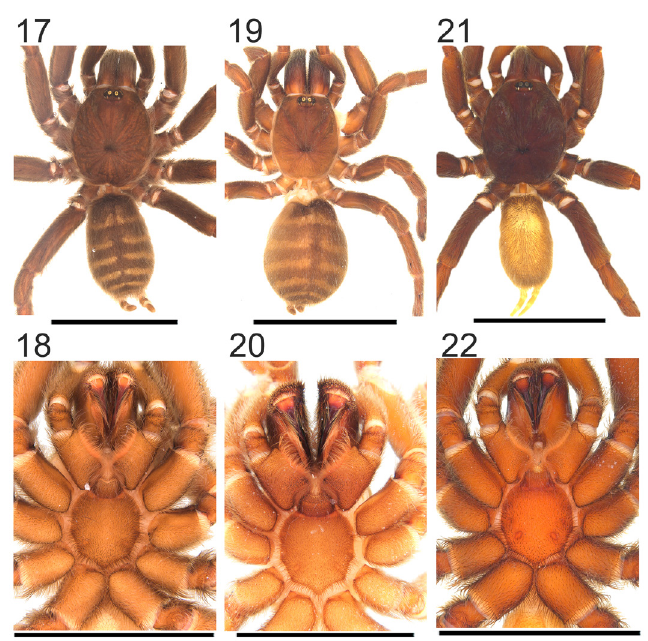
Figs 17–22. Schismatothele spp. 17–20 . Schismatothele timotocuica sp. nov. 17–18 . Holotype, ♂ (MZSP 28420). 17 . Dorsal view. 18 . Prosoma, ventral view. 19–20 . Paratype, ♀ (MZSP 26081). 19 . Dorsal view. 20 . Prosoma, ventral view. – 21–22 . Schismatothele wayana sp. nov., holotype, ♂ (MPEG 7363). 21 . Dorsal view. 22 . Prosoma, ventral view. Scale bars = 10